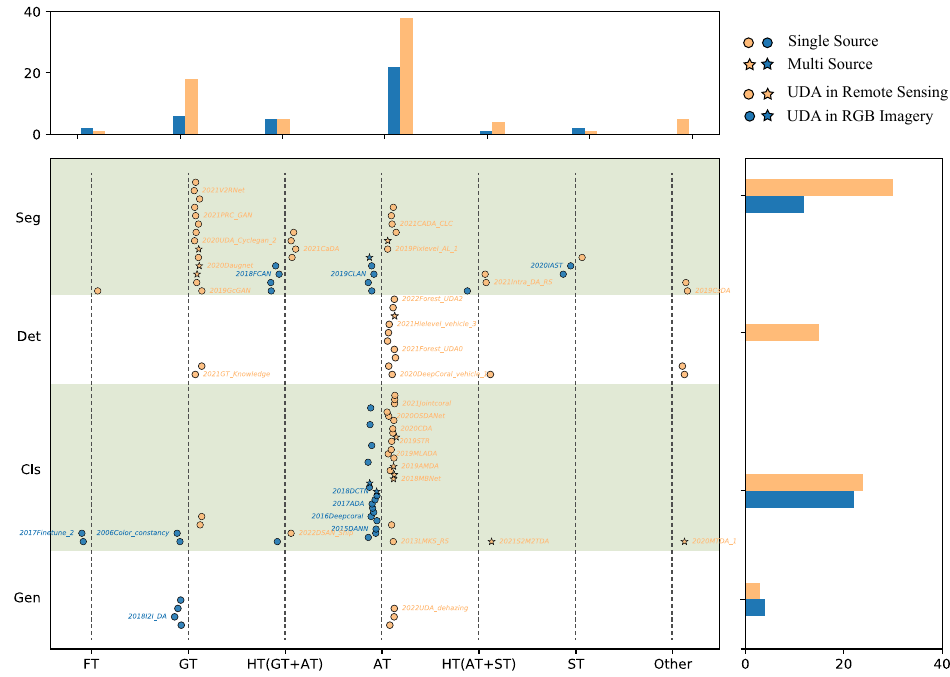
Figure 5. Relevant statistics of unsupervised domain adaptation methods sorted by published year, task and training mode, where geometric shapes in yellow and blue represent methods used in remote sensing and nature scenes, respectively. Circles and stars represent the single-domain and multi-domain methods, respectively. The horizontal axis of the bottom-left figure represents different training modes, where FT, GT, AT, ST and HT are Fine-tune, Generative, Adversarial, Self- and Hybrid training methods, respectively. The vertical axis of the bottom-left figure represents different tasks in the field of remote sensing, where Gen, Cls, Dec and Seg represent the Generation, Classification, Detection and Segmentation tasks,